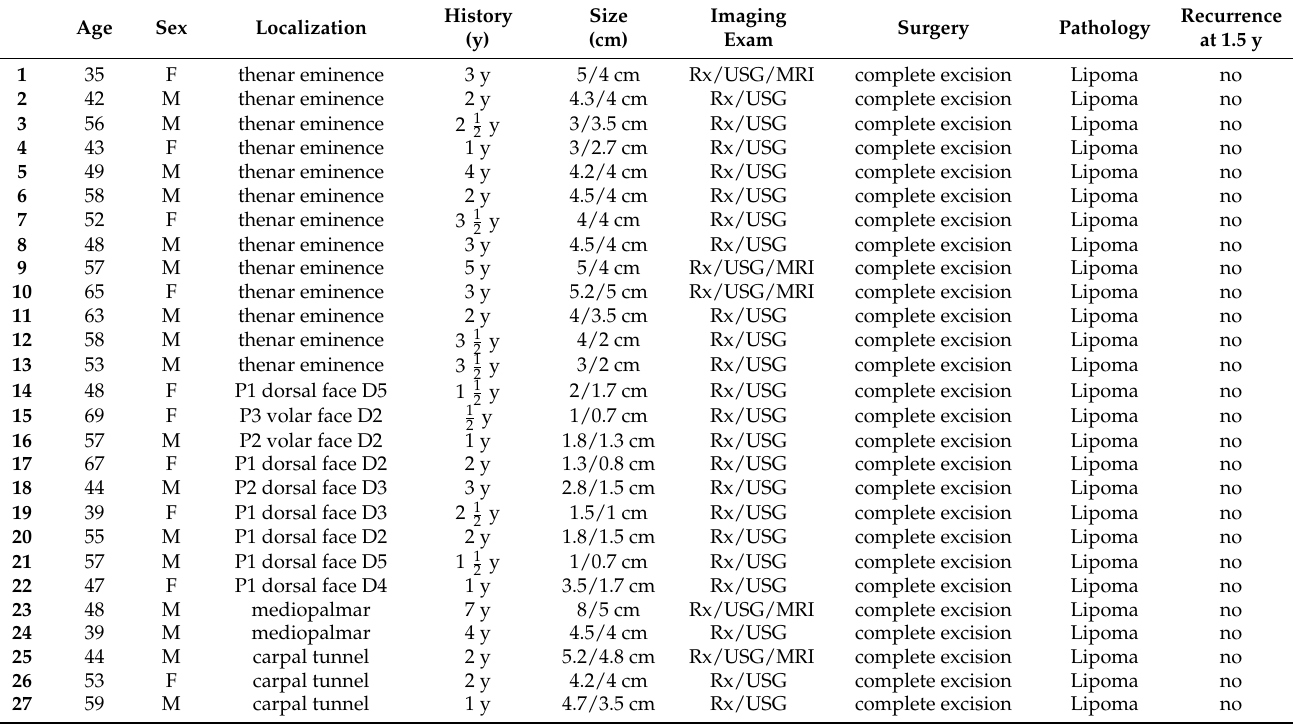
Table 1. Characteristics of the study group.